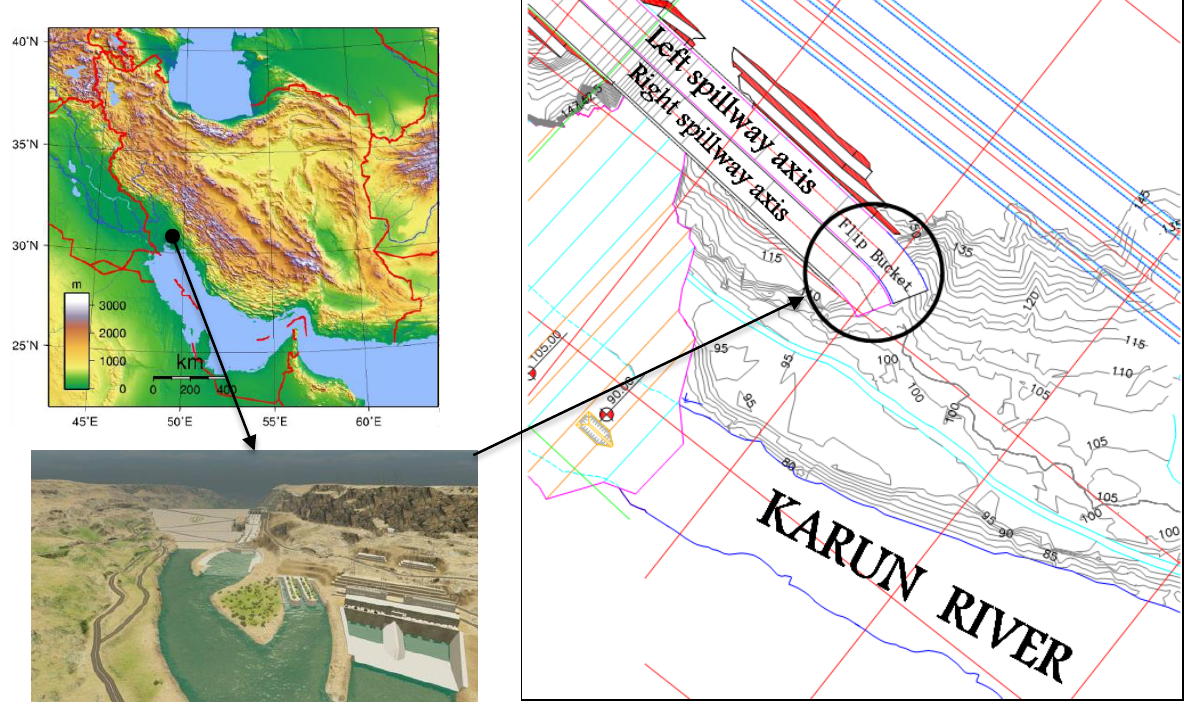
Figure 1. The location of the Upper-Gotvand Dam, Reservoir, and the Karun River (Iran)